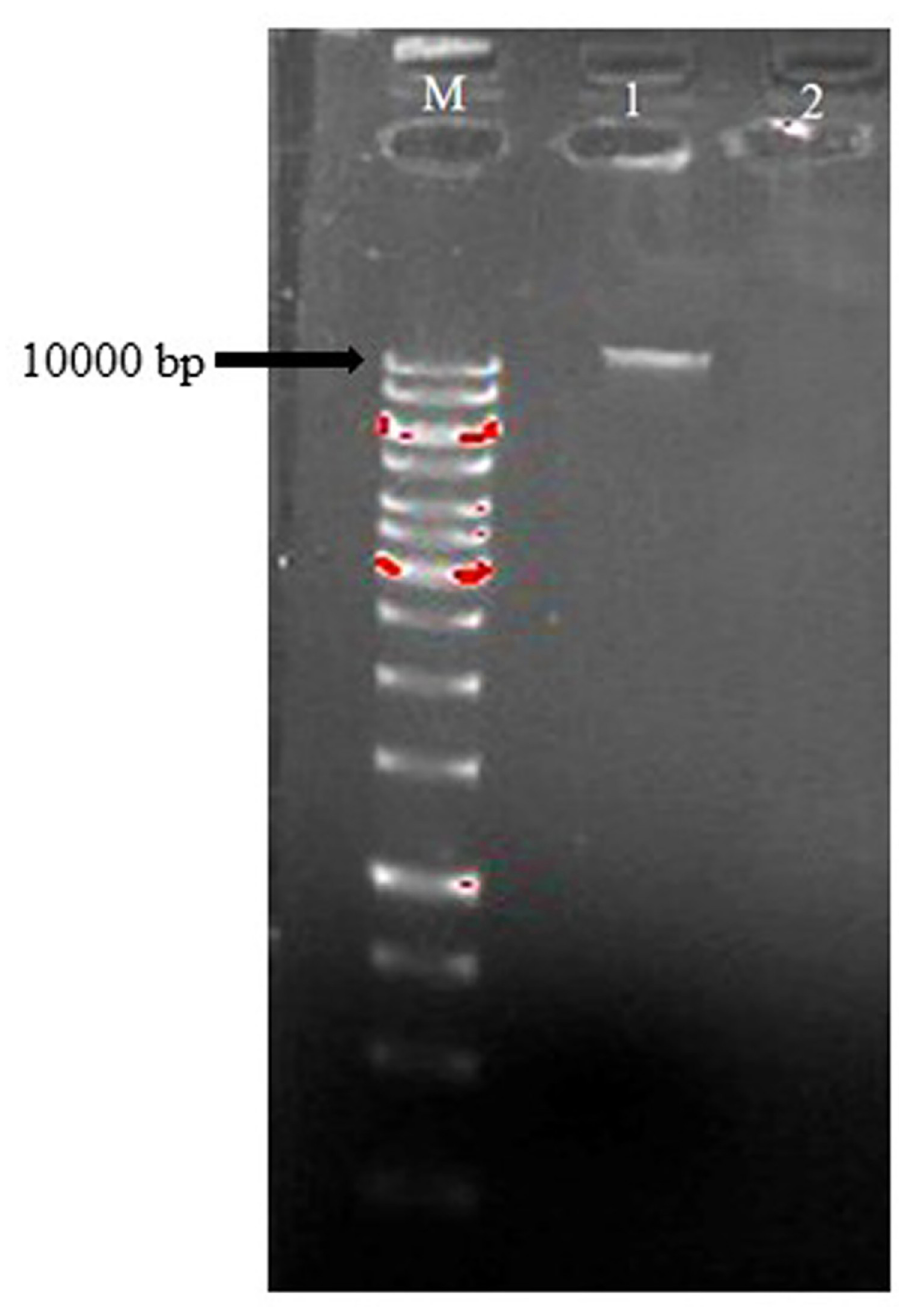
Fig 5. Detection of P . pentosaceus OBK05 plasmid DNA before and after plasmid curing. From left to right Lane (M): 1 kb DNA marker, Lane 1: Plasmid before curing, Lane 2: Plasmid after curing.